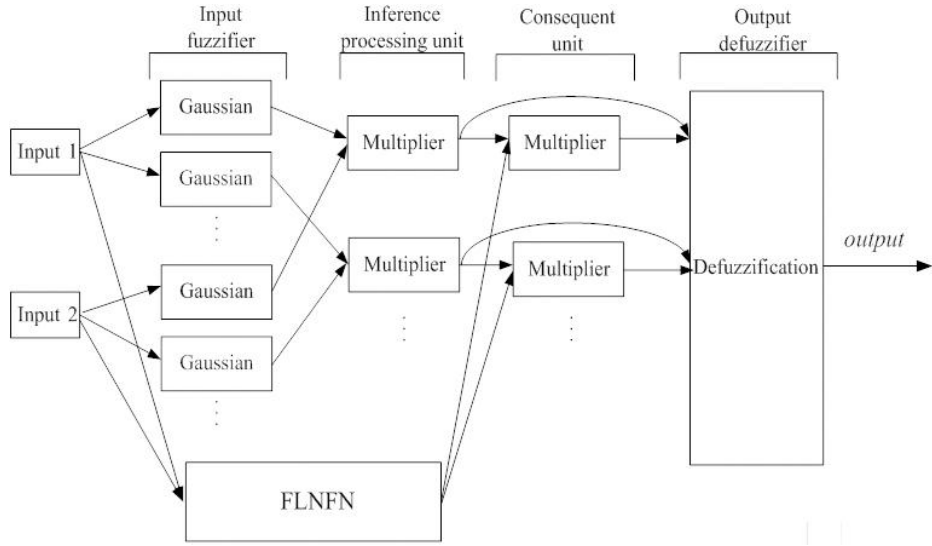
Figure 3. Architecture of FNFN.